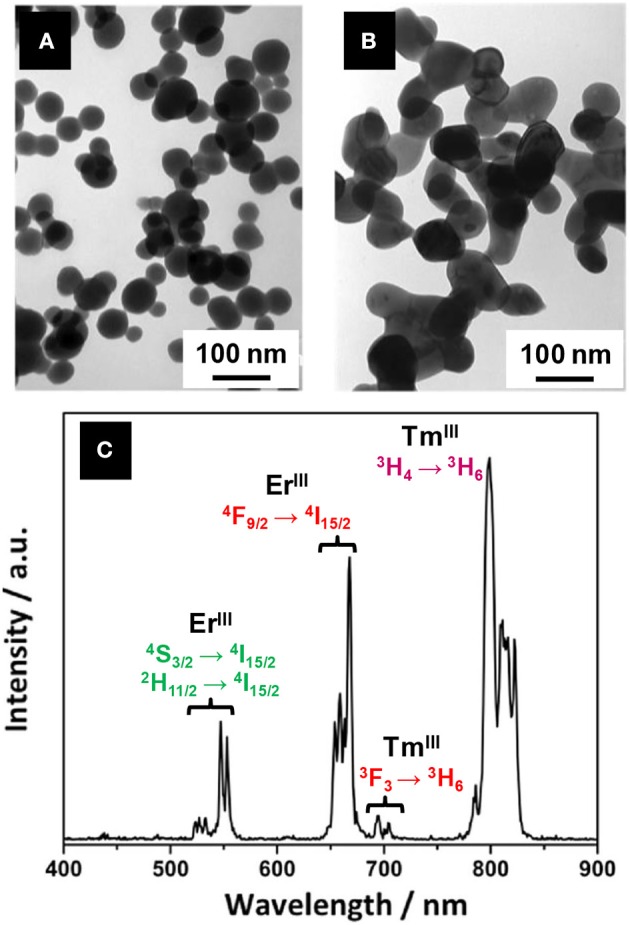
TEM micrographs of Y2O3:Er (A) and Y2O2S:Er@Y2O2S:Yb,Tm nanoparticles (B) synthesized by Tian et al. (C) Luminescence spectrum of Y2O2S:Er@Y2O2S:Yb, Tm nanoparticles under 1,550 nm excitation that exhibits the multicolor fluorescence of the core-shell nanoparticles (in the near-infrared region, between 780 and 830 nm, the 4I9/2→4I15/2 transition of ErIII was proven to play a minor role). Adapted from Tian et al. (2017) with permission of Elsevier.